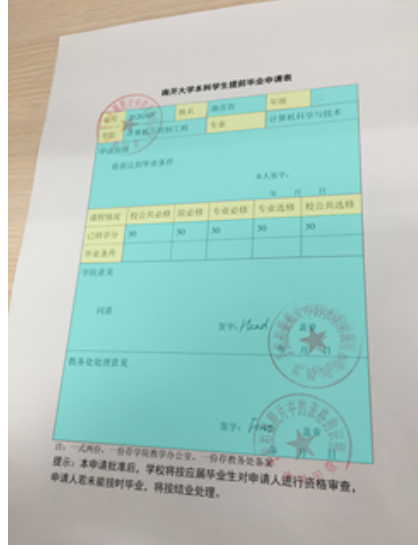
Figure 1. Table with perspective transformation and